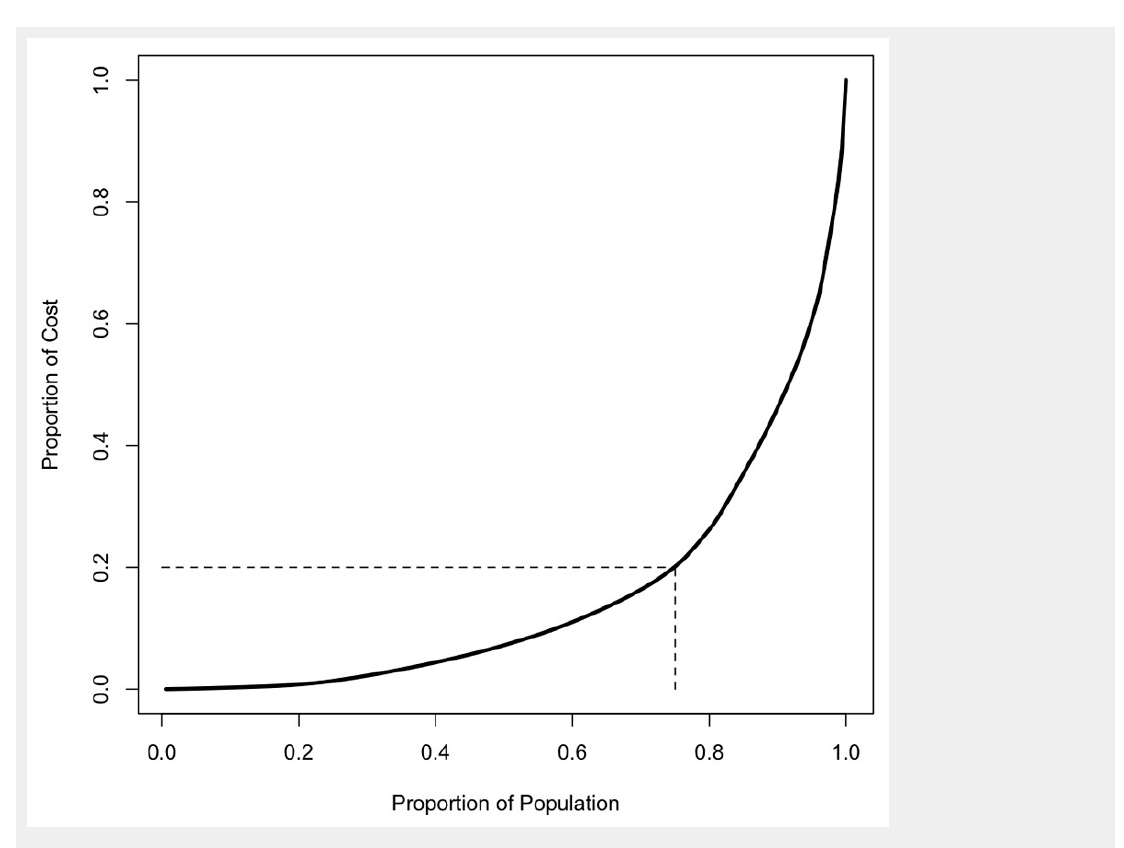
Figure 1 Concentration curve of direct medical costs of suicide attempts (n =